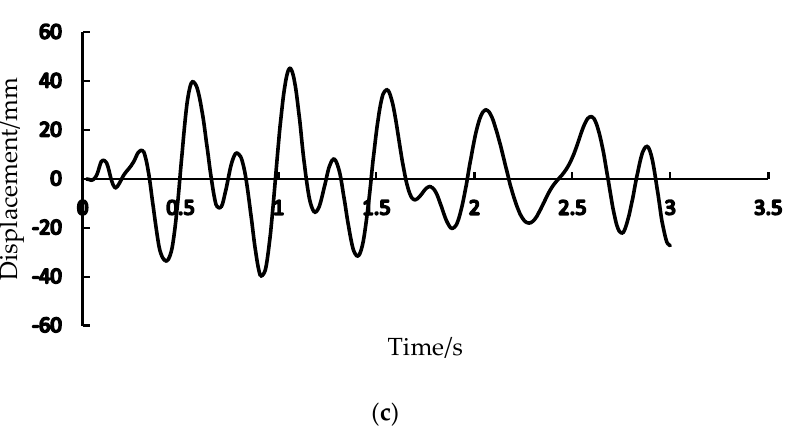
Figure 16. Displacement results for the left endpoint of the spray boom. ( a ) is the X-direction displacement of the left endpoint; ( b ) is the Y-direction displacement of the left endpoint; ( c ) is the Z-direction displacement of the left endpoint.